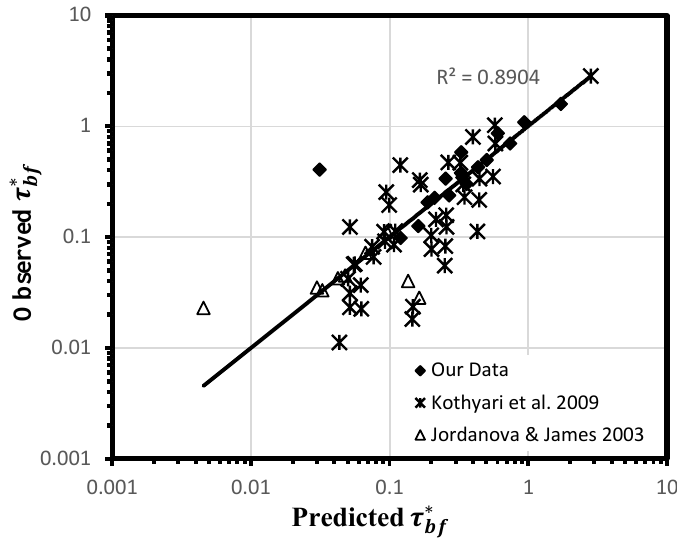
Figure 8. Scatter plot for predicted values of 𝜏 𝑏𝑓 ∗ (Equation (30)) and observed ones based on opti- mum parameter set [11, 12].